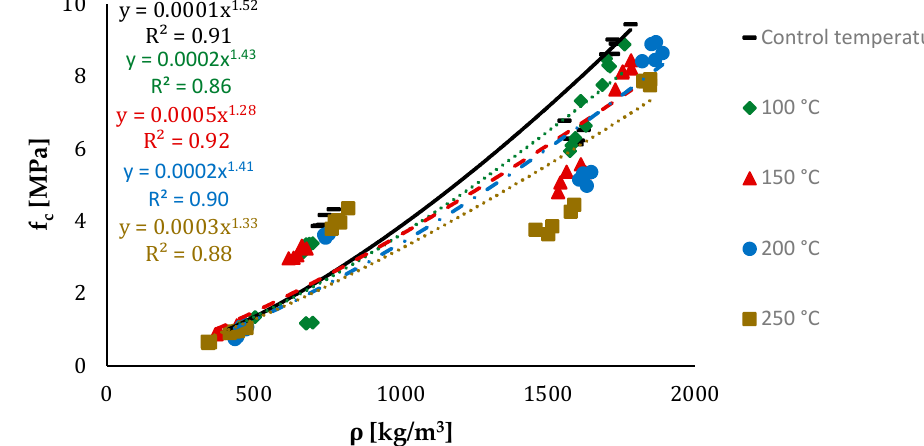
Figure 11. Relationship between bulk density and compressive strength.